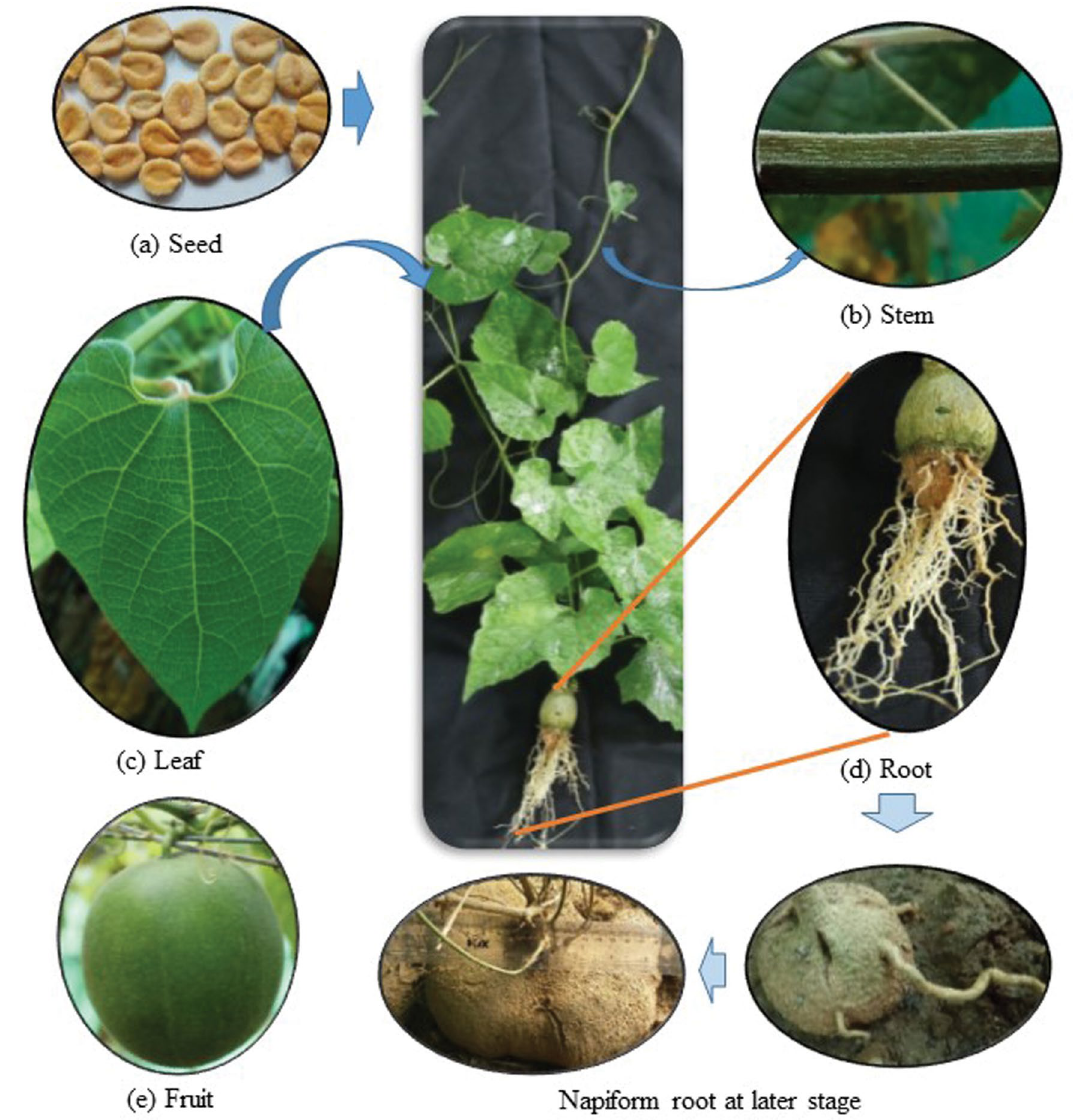
Figure 1. Different parts of Siraitia grosvenorii , seed (a) ; pentangular stem (b) ; heart shaped leaf (c) ; napiform root (d) ; and fruit (e)